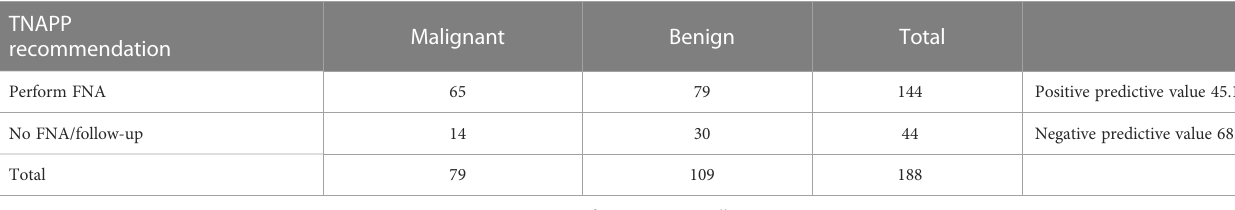
TABLE 7 Assessment of the overall TNAPP